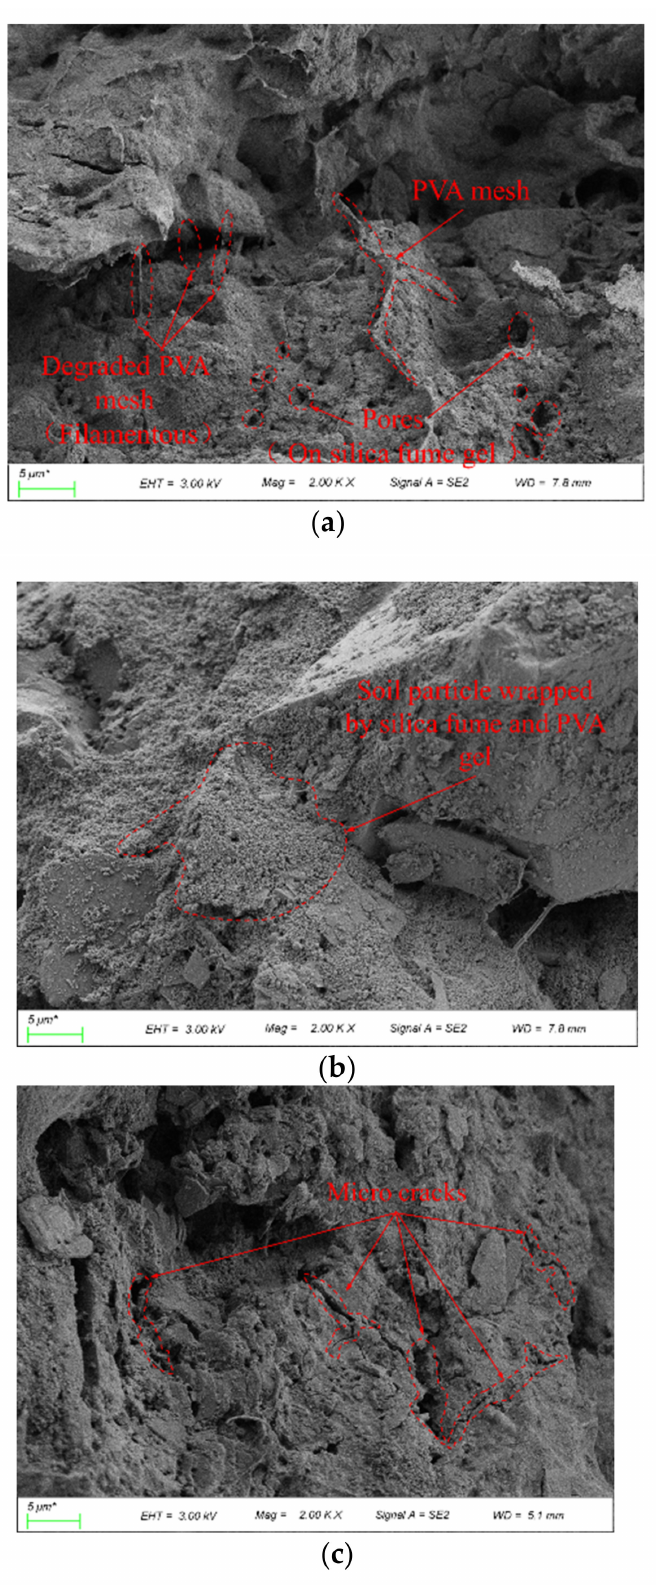
Figure 13. The microstructure of the samples stabilized by PVA and silica fume after 10 wet–dry cycles ( a ) 4% ( b ) 6% ( c )